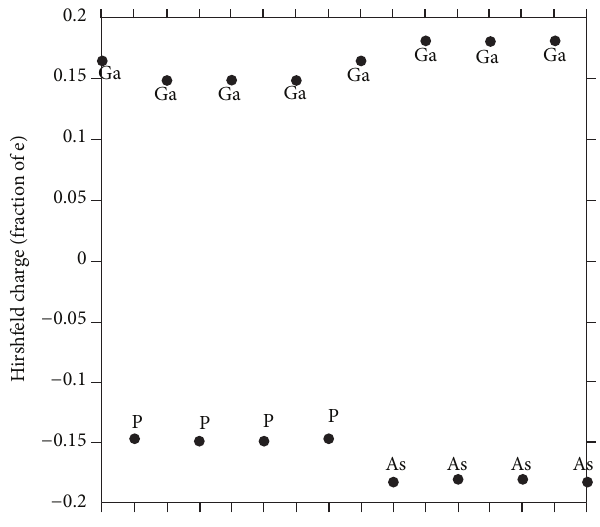
−0.2 Figure 8: Atomic Hirshfeld charges for short-period GaAs(4)/GaP(4) [001] superlattice calculated form the DFT electron density in real